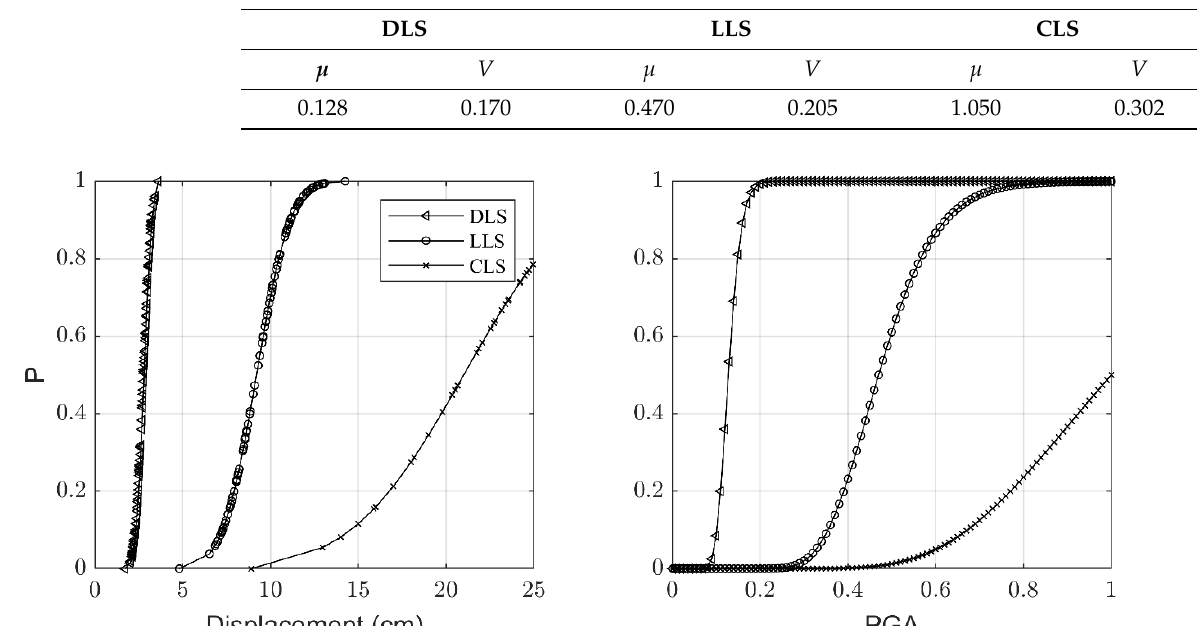
Figure 9. Fragility curves at the three considered limit states for the five-story building typology: LS-exceedance probability in terms of top displacement ( left ) and in terms of PGA, expressed in terms of g ( right ). The fragility curves only contain the capacity dispersion, while the demand dispersion can be further added after calibration or site-specific studies relevant to record-to-record variability.